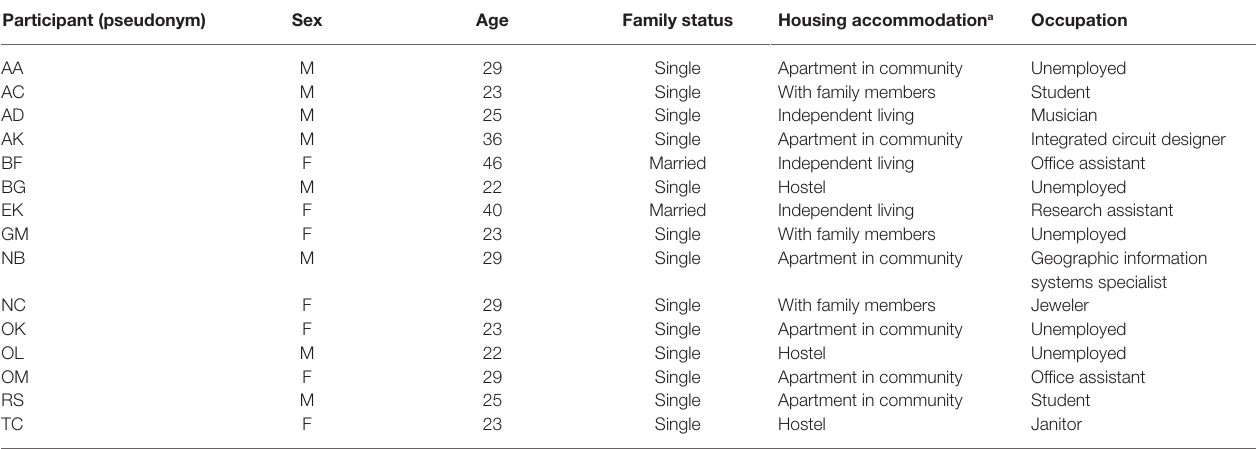
TABLE 1 | Participants’ personal